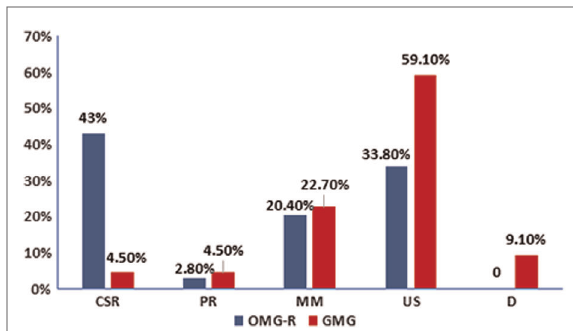
FIGURE 3 Outcome distribution in remained ocular myasthenia gravis and generalized myasthenia gravis groups. The number of patients who were followed for longer than 2 years in each group (OMG-R or GMG) were calculated based on different outcomes. CSR, complete stable remission; PR, pharmacologic remission; MM, minimal manifestation; US, unstable (including improved, unchanged, worsened and exacerbated); D,